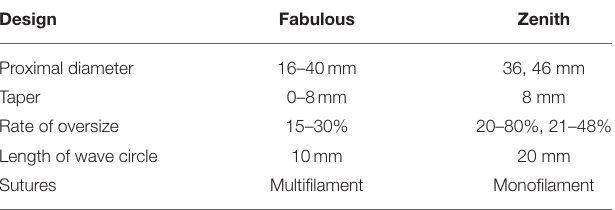
TABLE 2 | Design differences Fabulous vs.